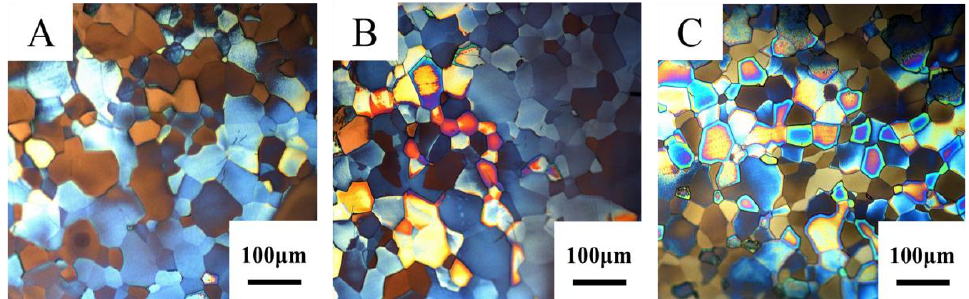
Figure 2. Metallographic structures of Ti targets with different purities. ( A ) Target A; ( B ) Target B; ( C ) Target C.